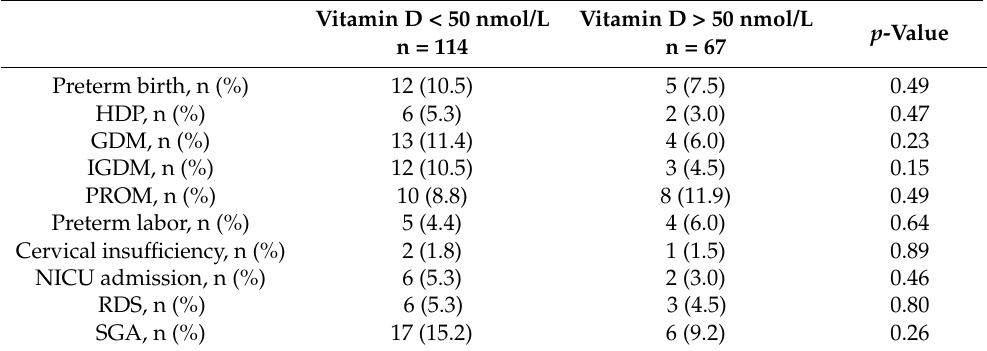
Table 2. Vitamin D deficiency in the first trimester and association with complications in singleton pregnancies presented as absolute frequencies and percentages in